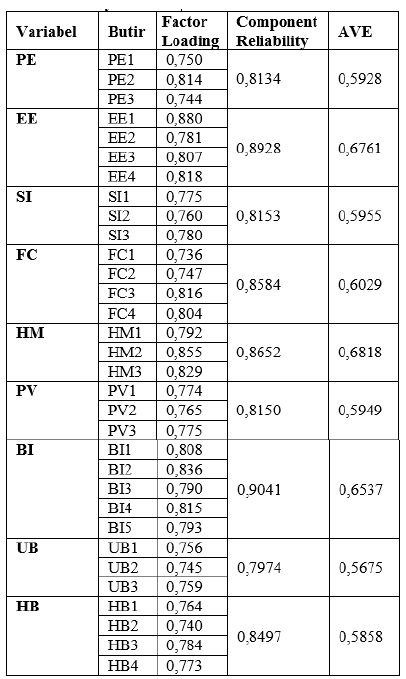
Table 1. Reliability and